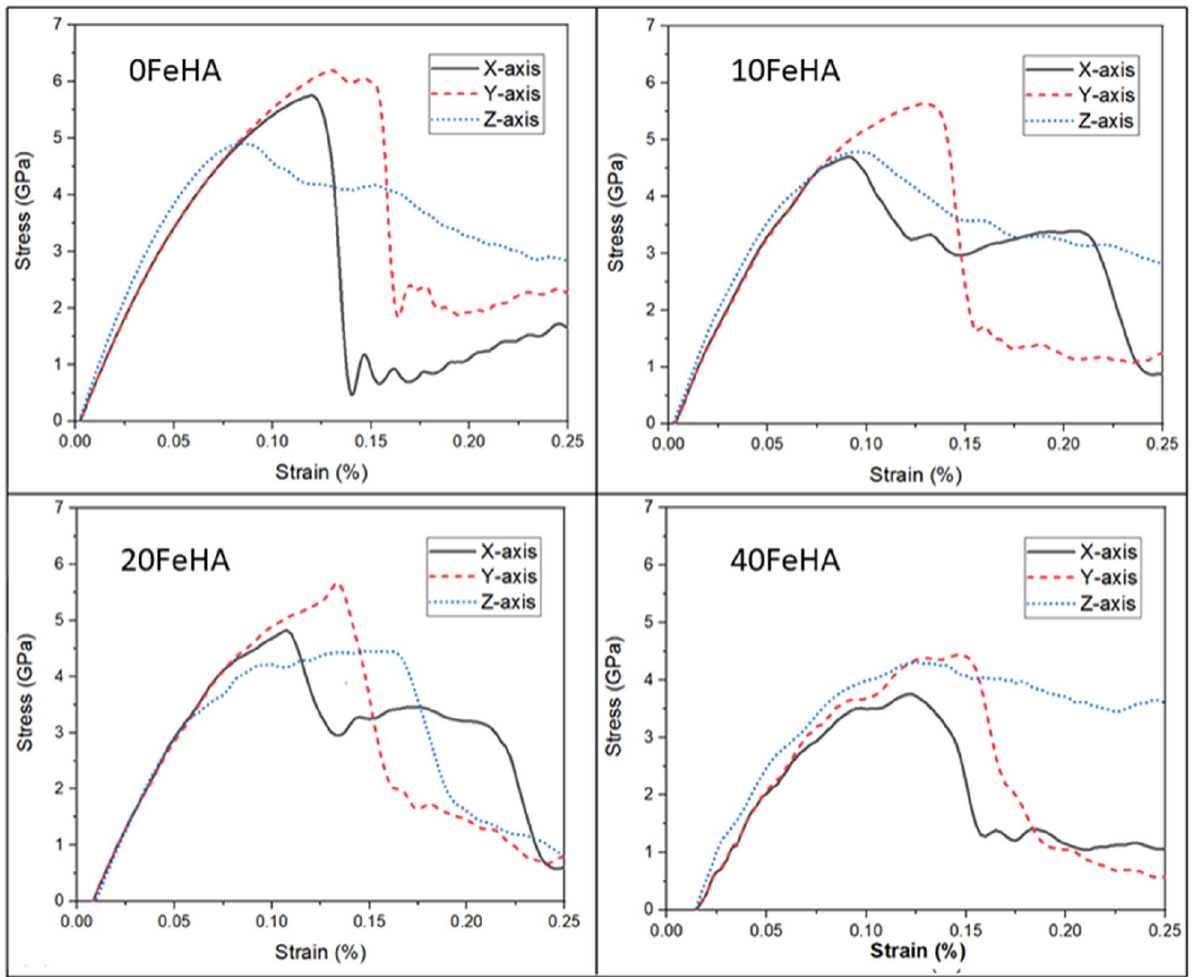
Figure 5. Uniaxial tensile stress–strain response at T = 10 K for different doped HA, as analyzed using MD simulation. (Sample designation: xFeHA means x mol% Fe 2+ -doped HA). The tensile loading directions along different crystallographic orientations follows similar manner as shown in Fig. 1.